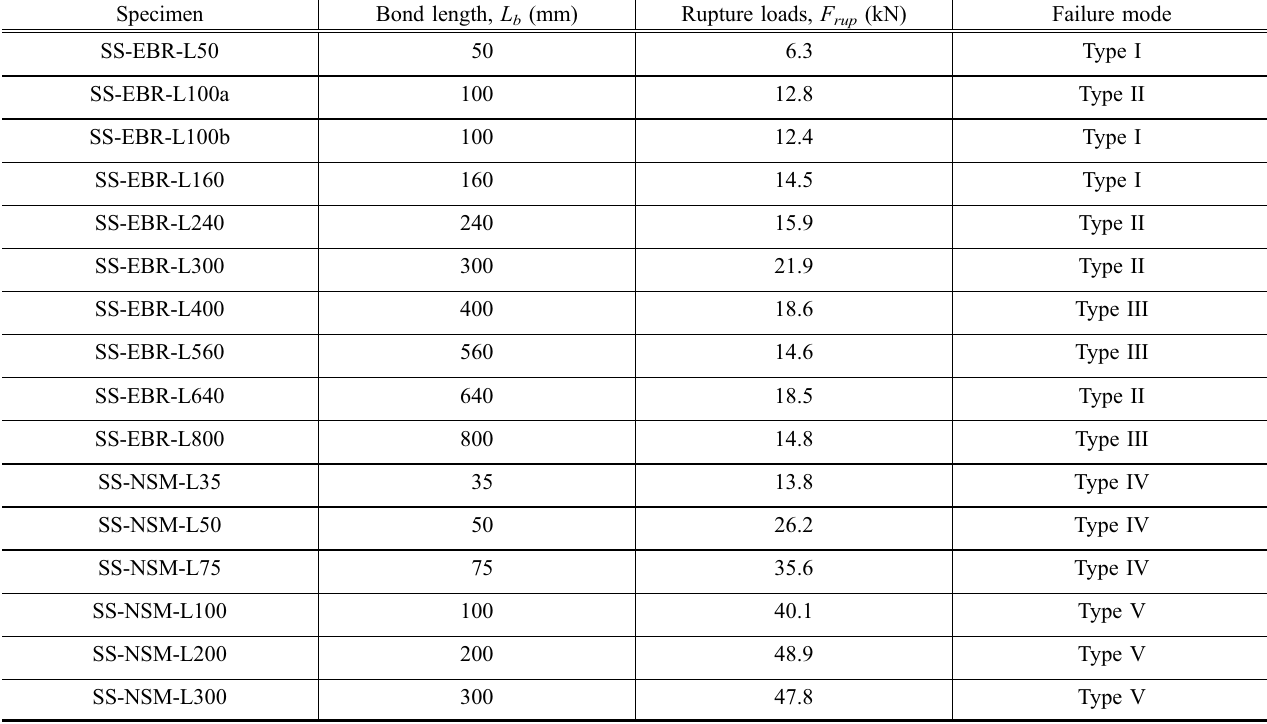
Fig. 6 Common failure modes observed from the single-lap shear tests: a EBR samples; and b NSM samples. Table 3 Rupture loads and rupture modes observed in the